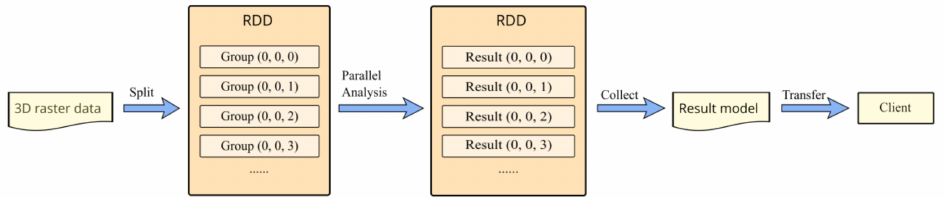
Figure 9. Workflow of a parallel geological analysis for 3D raster data through the group-based method. In the colocation-based and the default Hadoop replica placement, corresponding data splitting methods are used instead of the group-based division.